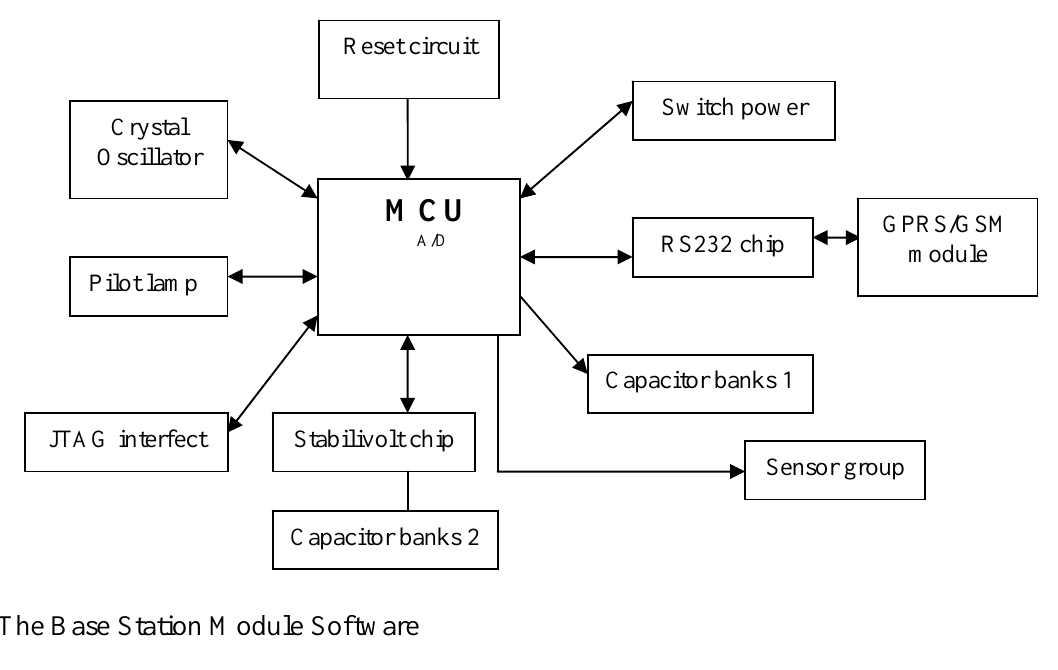
Figure 2. Hardware components of the base station module.